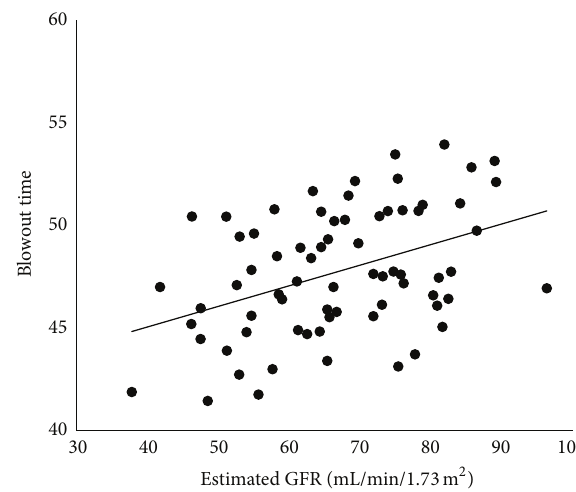
Figure 2: Correlation between blowout time and serum creatinine in all subjects.